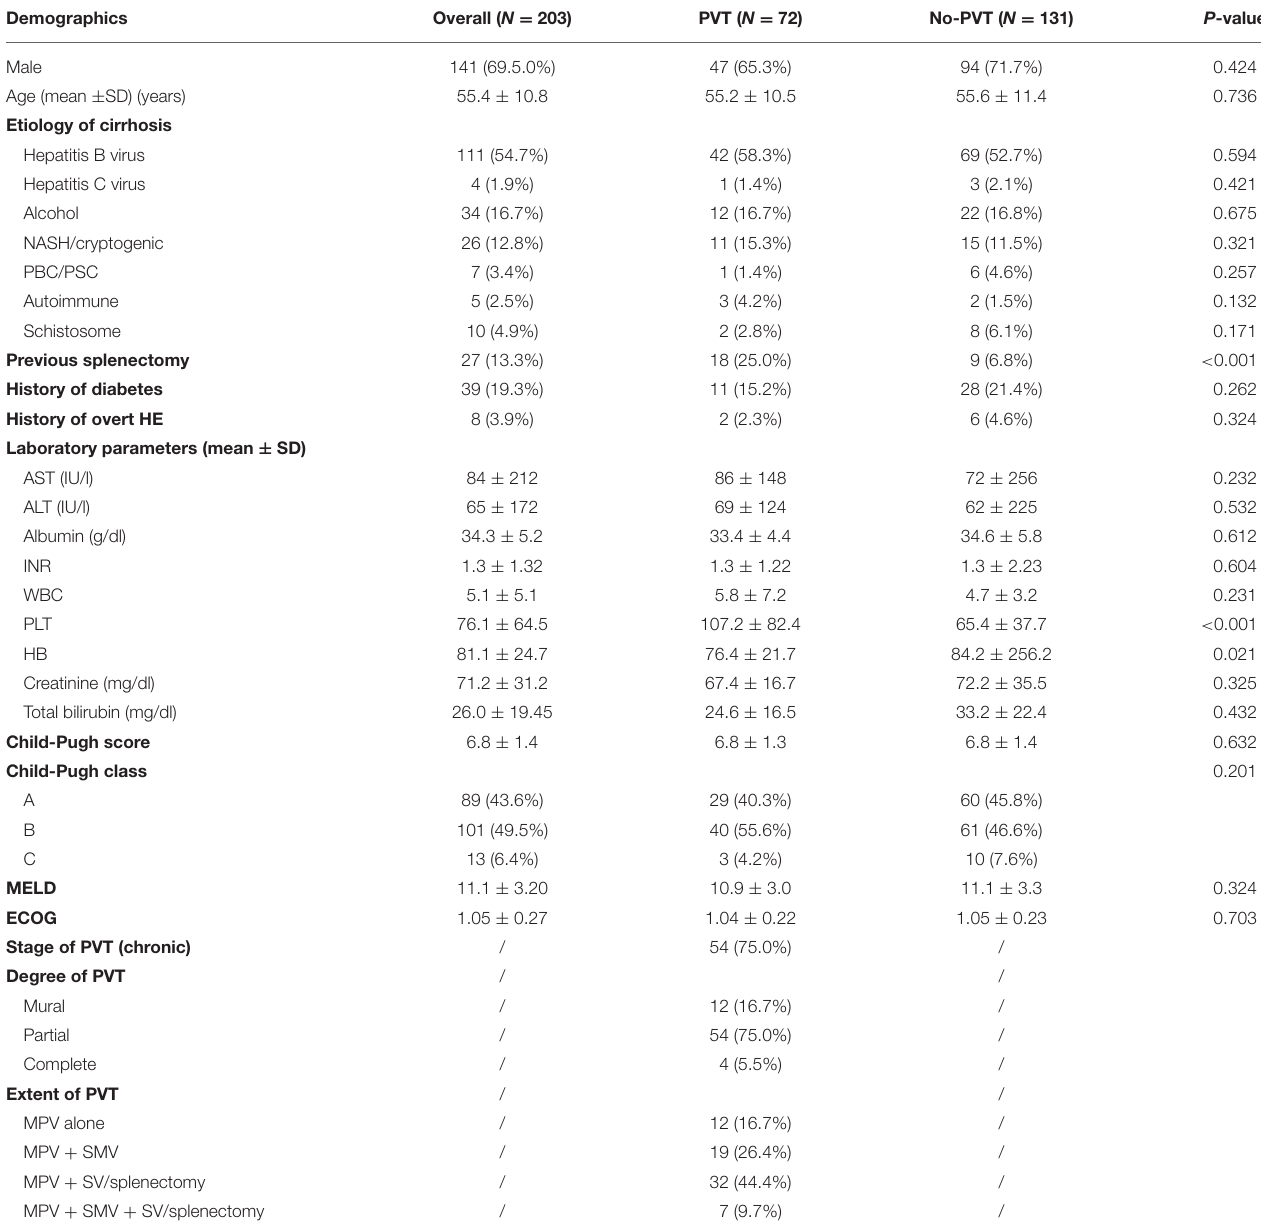
TABLE 1 | Baseline demographic and clinical characteristics of patients.